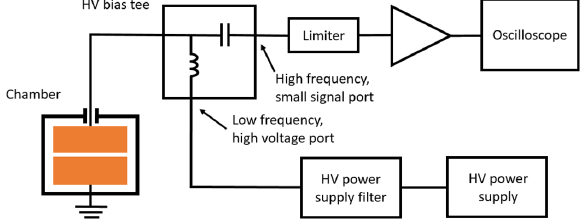
FIG. 3. Block diagram of the setup used to measure dark current fluctuations.